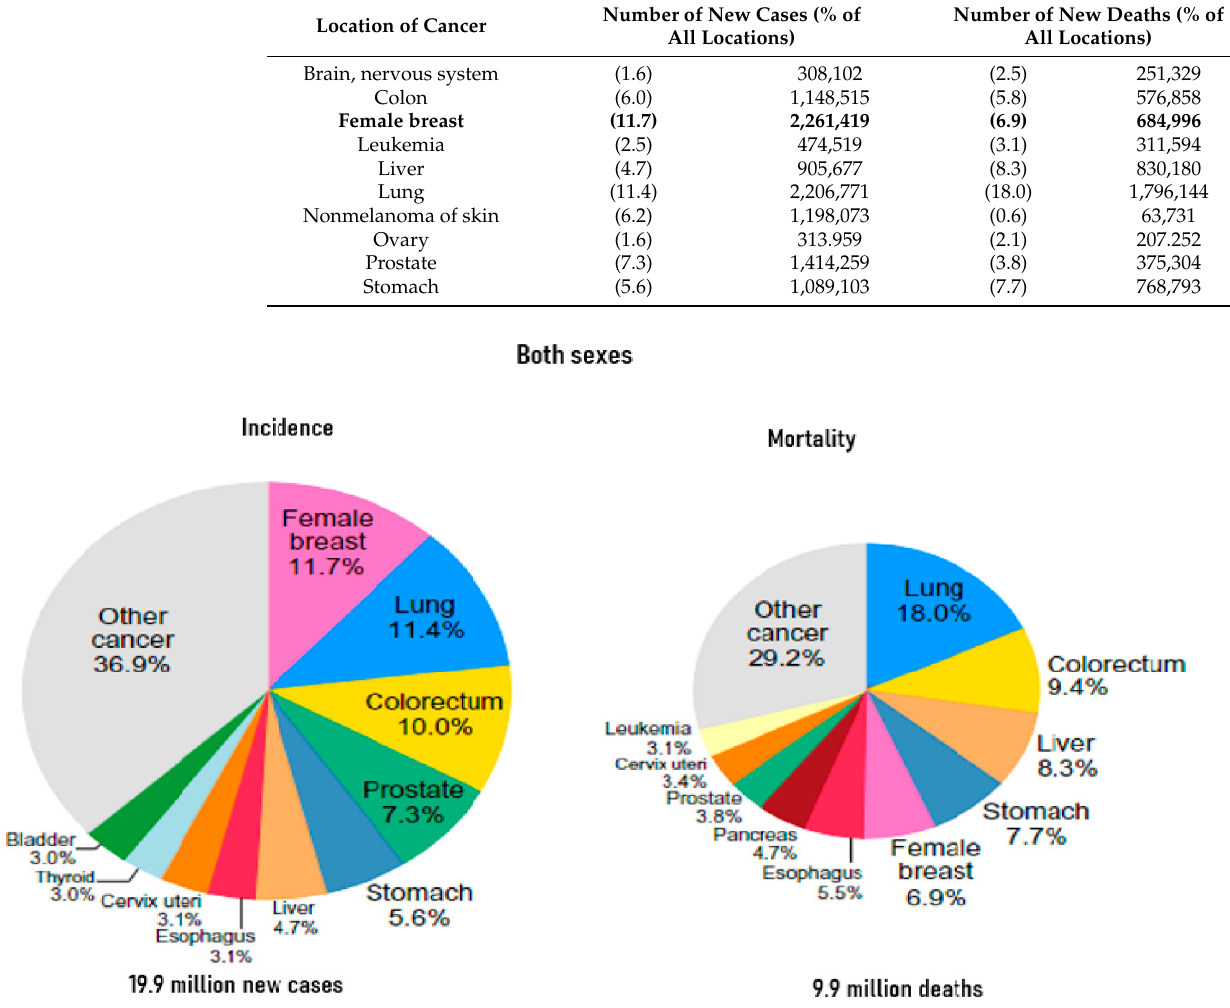
Figure 1. Distributing the Cases and Deaths of the 10 Prevalent Cancers in 2020 for Both Sexes